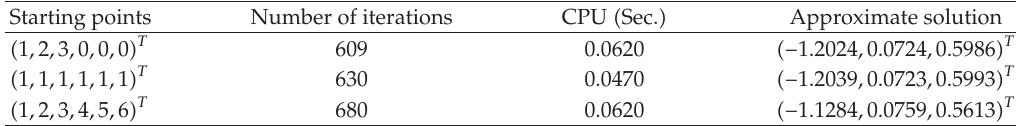
Table 5: Results for Example 6.2 using FB type HRP method.